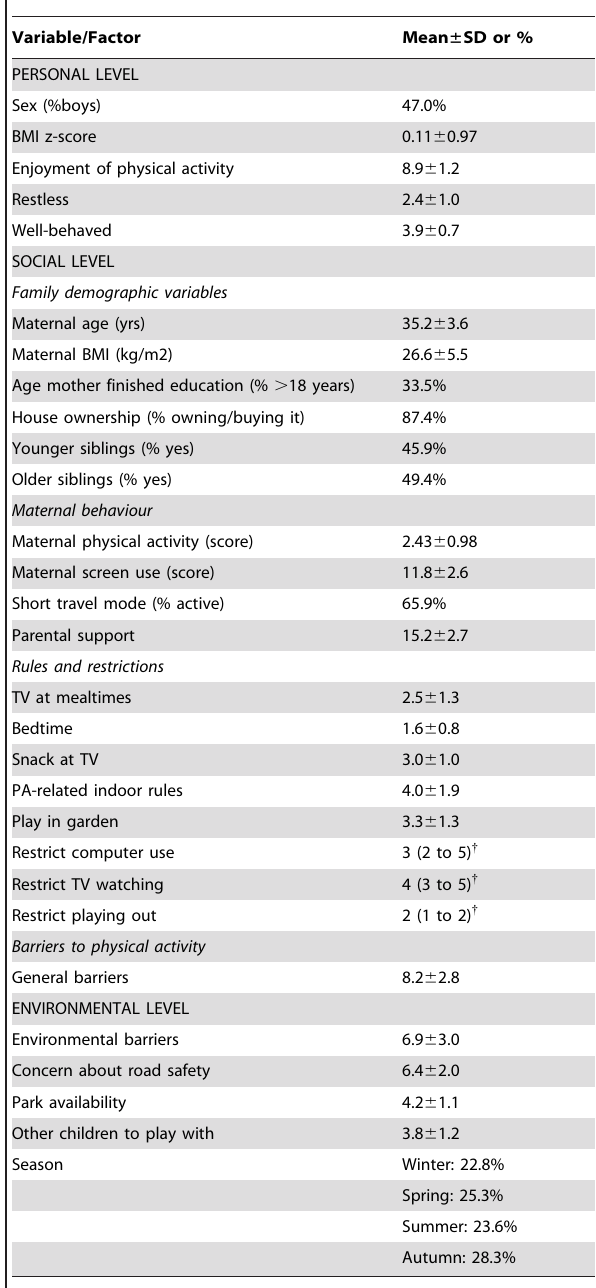
Table 1. Distribution of putative correlates of four-year olds’ physical activity (please see Table S1 for a detailed description of the